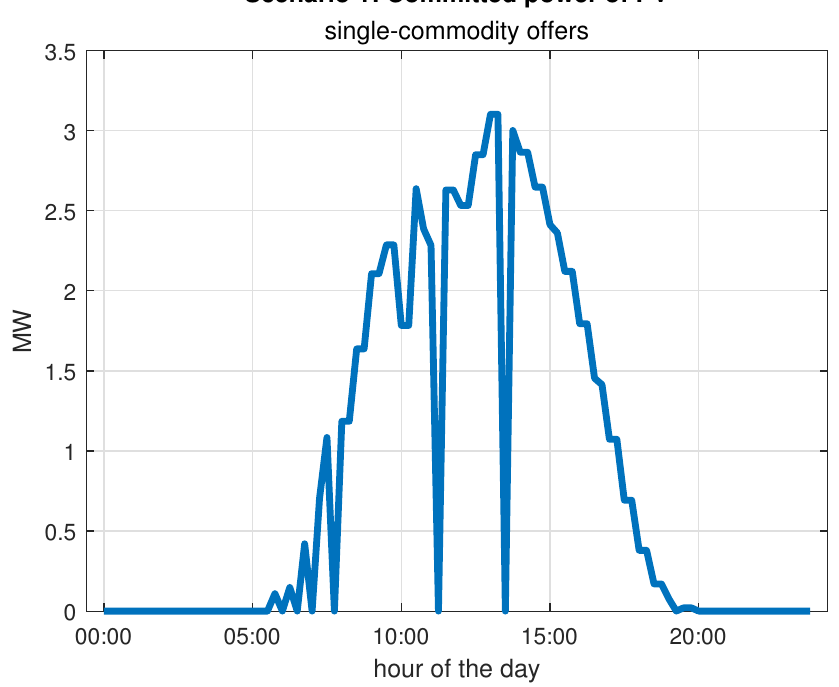
Figure 4. PV generation profile when only single-commodity offers are submitted.